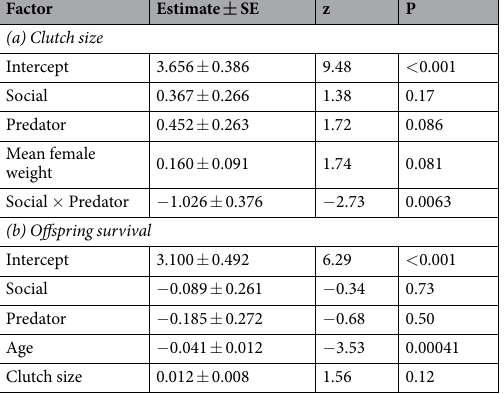
Table 2. Results of GLMMs to analyse the effects of early social and predator environment on (a) clutch size (N = 38) and (b) survival of the second brood (N = 32).